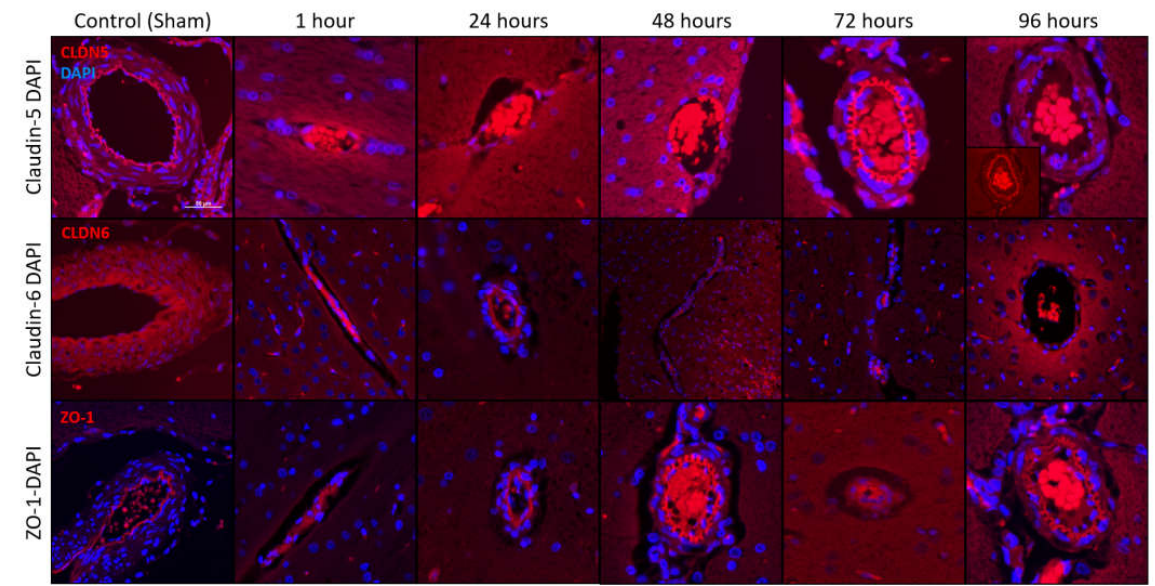
Figure 3. Immunofluorescent staining of transverse brain samples following intracranial H-FIRE revealed decreased claudin-5 (CLDN5) and zonula occludens (ZO-1) reactivity by 1 h post treatment, followed by a gradual increase in reactivity over time. Claudin-6 (CLDN6) reactivity was greatest at 24 h post-H-FIRE treatment, and relatively decreased at all other time points compared to sham controls. Images were captured at 200 × magnification. The scale 50 µ m is consistent across all